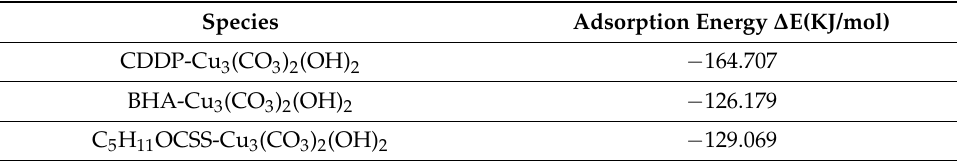
Table 5. The adsorption energy between collectors and